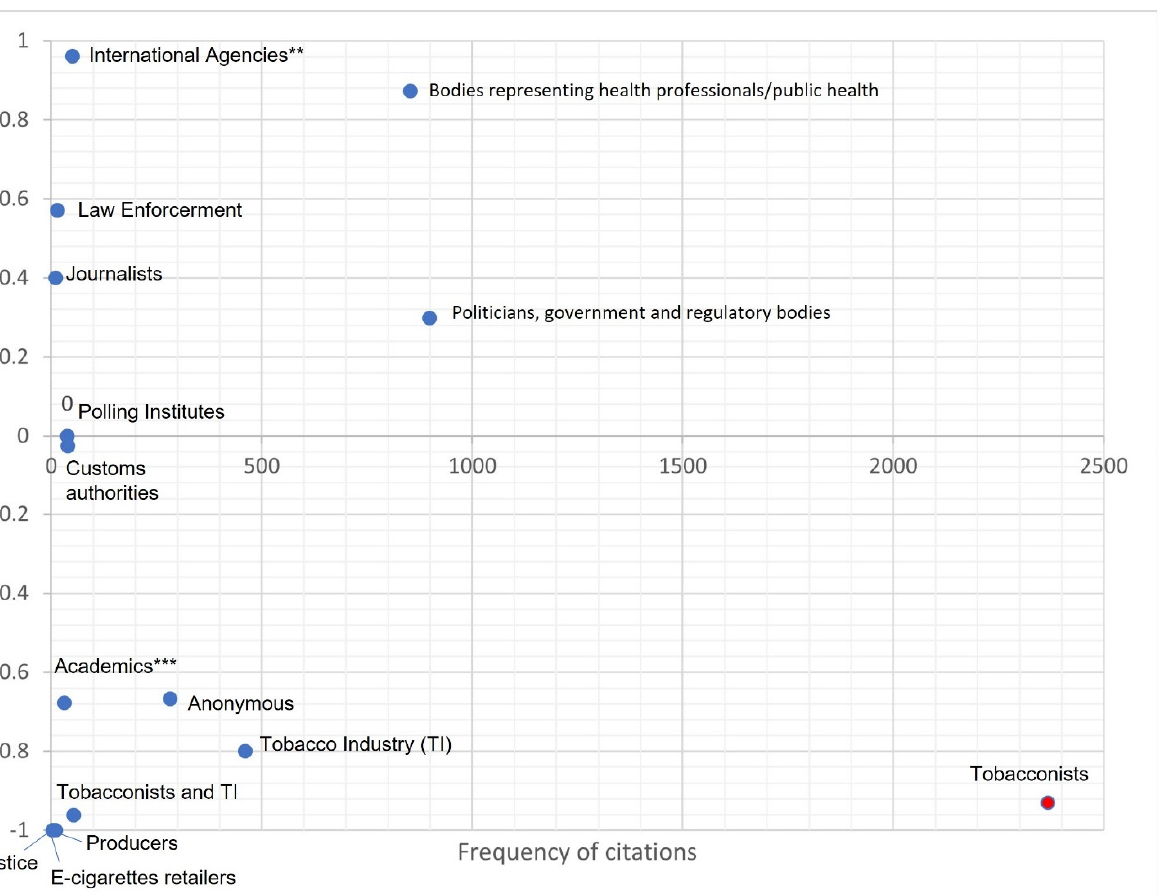
Figure 3. Frequency of citations per speaker-constituency and valence of their discourse. * Scored on the scale from -1 “strongly opposed to tobacco tax increase” to +1 “strongly in favour of tobacco tax increase”. ** “International” Agencies refer to the WHO and the World Bank. *** “Academics” stands for researchers working in other fields outside medicine or public health (economics, history etc.).